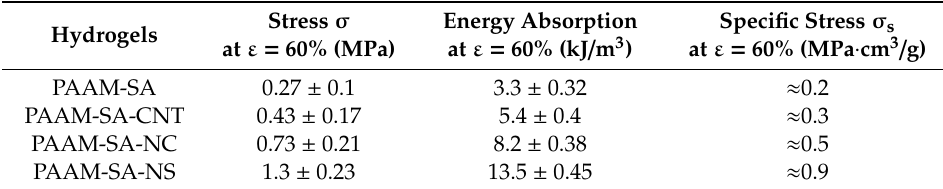
Table 1. Physical and compression properties of